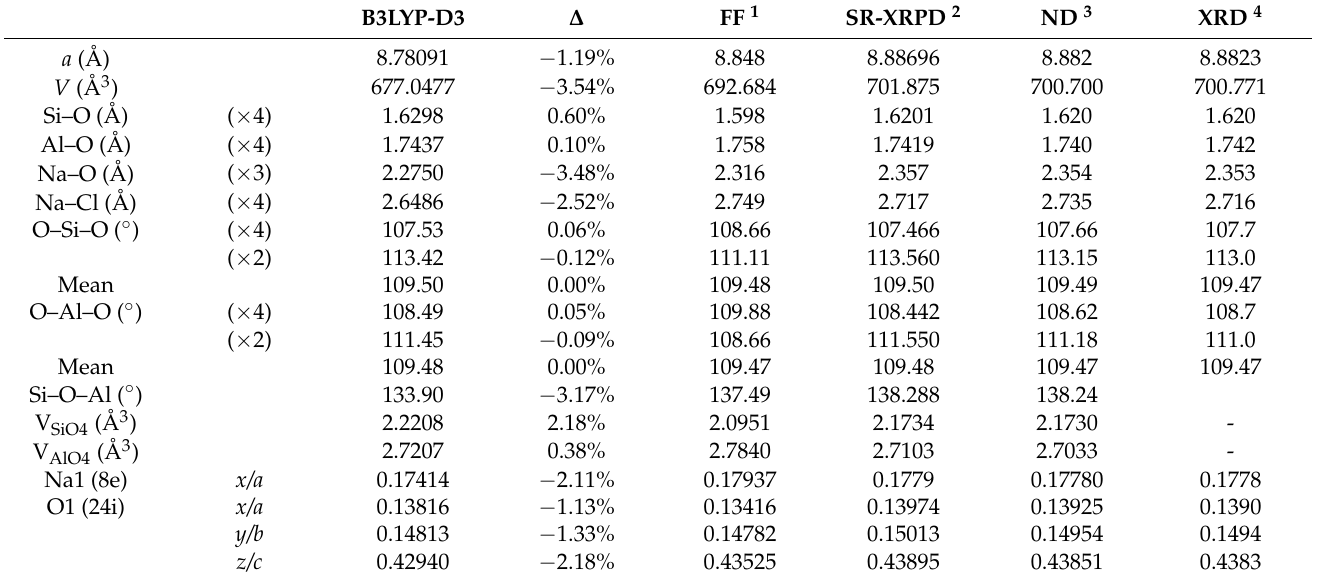
Table 1. Zero-pressure (equilibrium) structure of sodalite Na 8 (Al 6 Si 6 O 24 )Cl 2 , with a the lattice param- eter and V the unit cell volume, and internal geometry (atomic distances, bond angles, polyhedral volumes and relevant atomic fractional